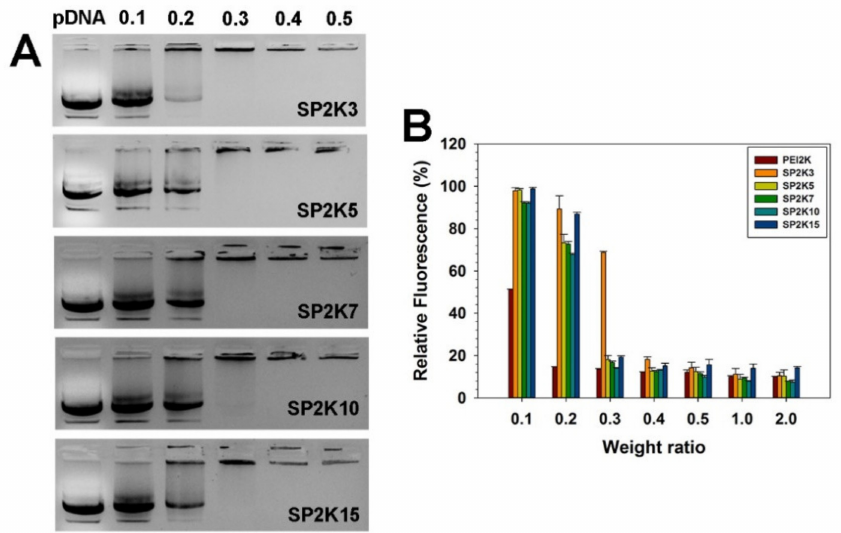
Figure 2. ( A ) Agarose gel electrophoresis result and ( B ) PicoGreen assay result of SP2K polyplexes. Numbers in ( A ) refer to the weight ratios of the polyplexes. Error bars in ( B ) indicate the standard deviations ( n =